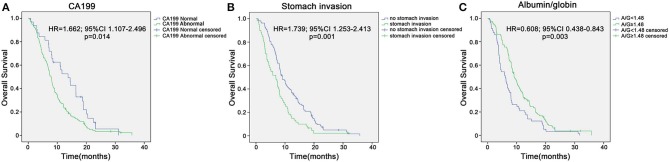
Kaplan–Meier overall survival curves for the patients with unresectable pancreatic cancer in the training sample of 168 patients. (A) Overall survival of patients with abnormal CA199 decreased significantly compared with that of patients with normal CA199 (median survival, 7.80 vs. 13.73 months, p < 0.05). (B) Overall survival of patients with stomach invasion decreased significantly compared with that of patients with no stomach invasion (median survival, 6.83 vs. 9.10 months, p < 0.05). (C) Overall survival of patients with low AGR decreased significantly compared with that of patients with high AGR (median survival, 6.10 vs. 9.10 months, p < 0.05).